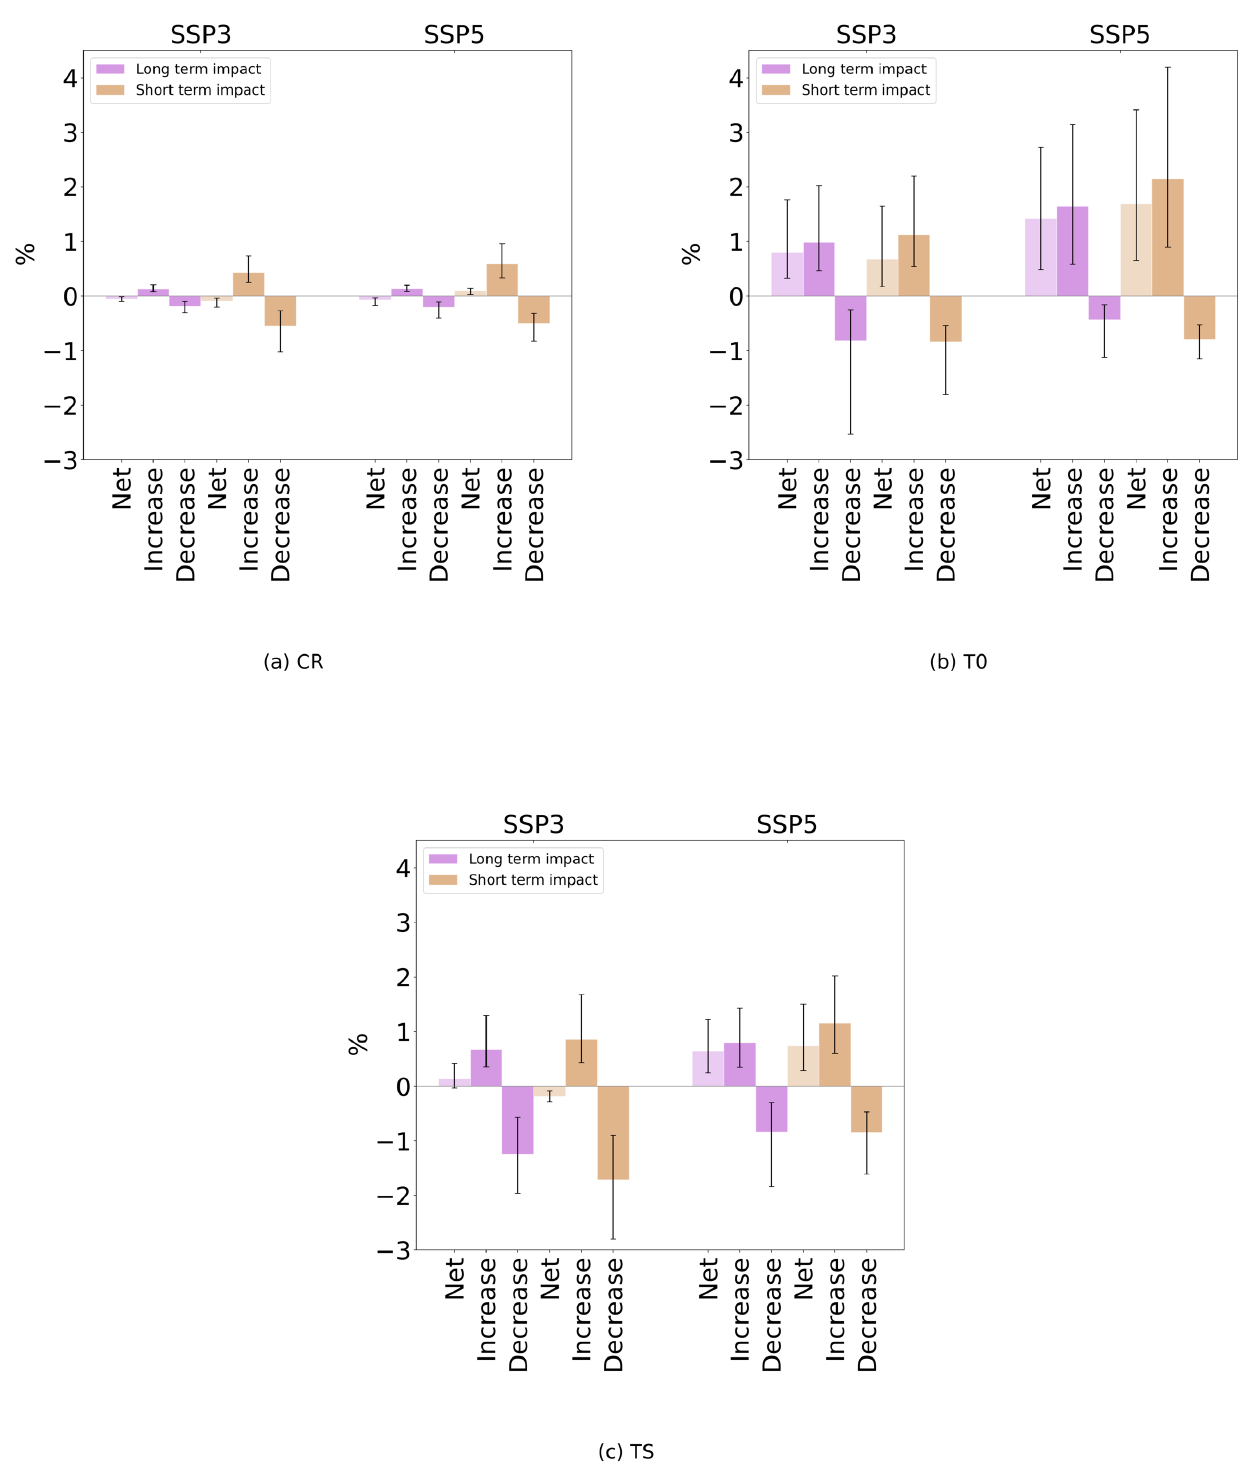
Fig 3. Mean global migration change due to the climate change impact, for each SSP scenario, climate change impact method and emigration rates assumption. The change, in percentage, is computed as the difference of migration under the climate change impact scenario and the baseline case without climate change impact, divided by the baseline case. Positive values define an increase under climate change impact. Flows are averaged over the period of 30 years where the 3˚C global warming level is reached (see Methods). For each case we show separately the total (net) change of migration, the change in the total flows that increased and in those that decreased. The error bars represent the extremes reached within the ensemble of GCMs that we use, while the bars show the mean value reached within the set of GCMs. Each panel refers to one assumption regarding emigration rates.